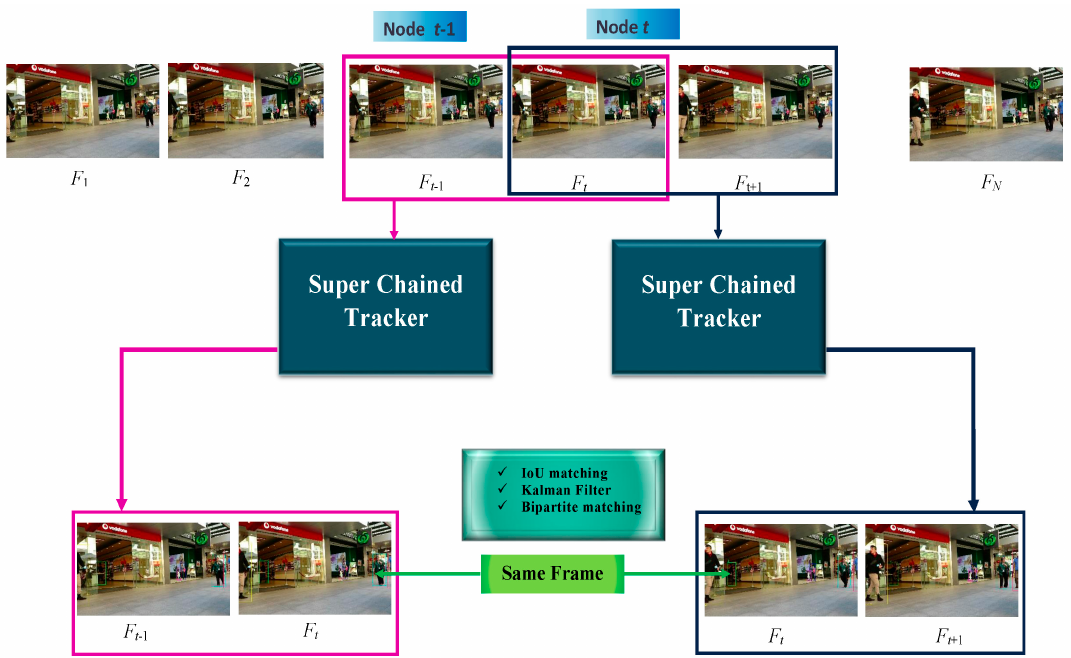
Figure 1. Schematic details of the chaining node: the pair of bounding boxes denoted by ( B t − 1 , ˆ B t ) generated, and after that, SCT exploits two random adjacent nodes represented by ( F t − 1 , F t ) and ( F t , F t+ 1 ). Subsequently, IoU matching, Kalman filtering, and Bipartite matching are used on the common frame for sequencing the two nodes. The long trajectories are generated for the video sequence by using adjacent nodes, and chaining is performed sequentially.